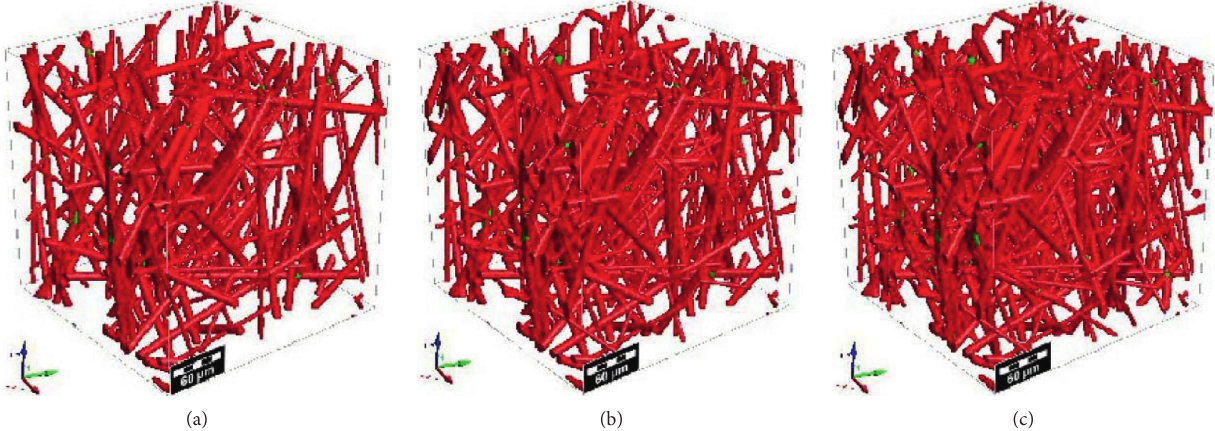
Figure 11: RWB model with different SVF distributions (mean diameter � 10.5 μ m): (a) SVF � 3.70%; (b) SVF � 4.72%; (c) SVF � 6.08%.